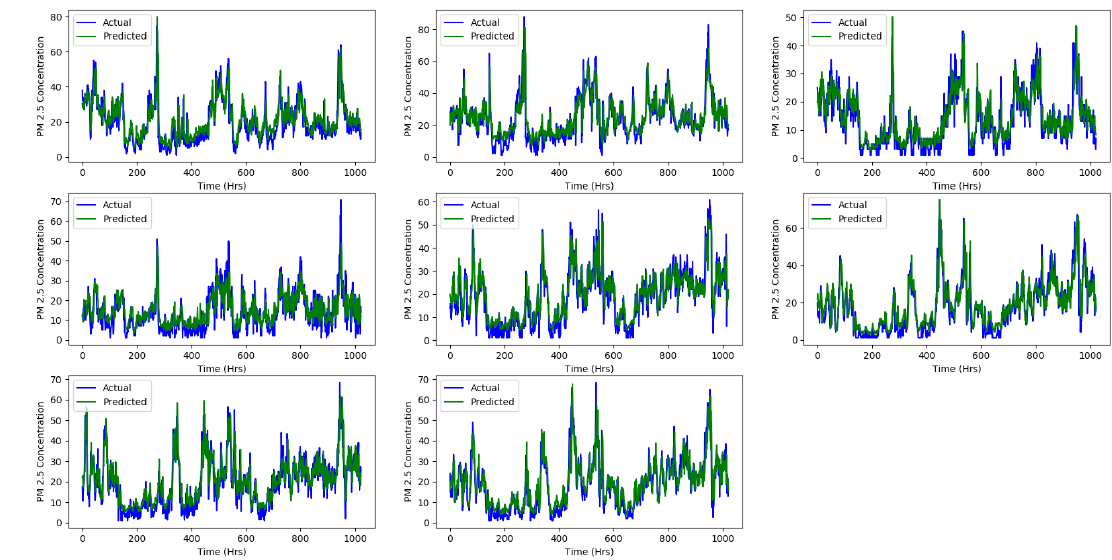
Figure 6. The predicted results of